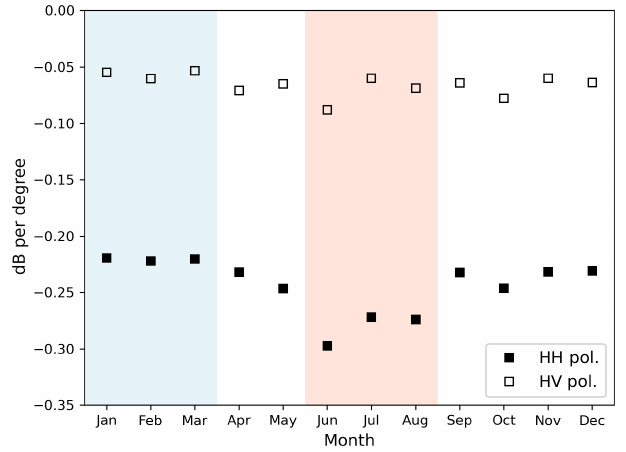
Figure 4. Incidence angle dependences of sigma naught in HH (closed squares) and HV (open squares) polarization channels. Pix- els covering various types of sea ice were merged so that the av- eraged property can be estimated. The blue and red zones indicate winter and summer seasons, respectively. Table 1. Hyperparameters used for grid search. Parameters